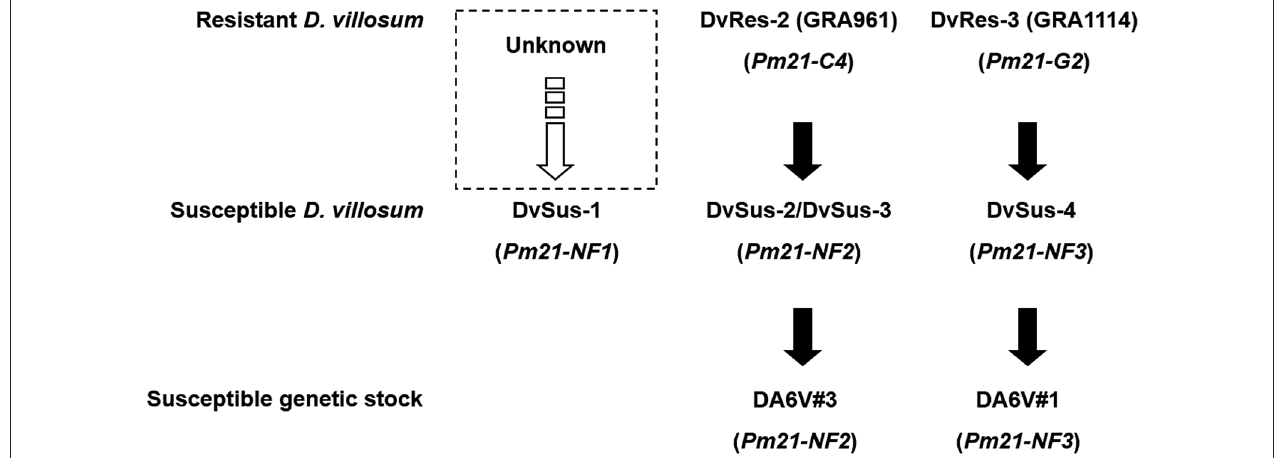
FIGURE 6 | Origins of the non-functional alleles Pm21-NF1 to Pm21-NF3 . Among them, the origin of Pm21-NF1 is unclear